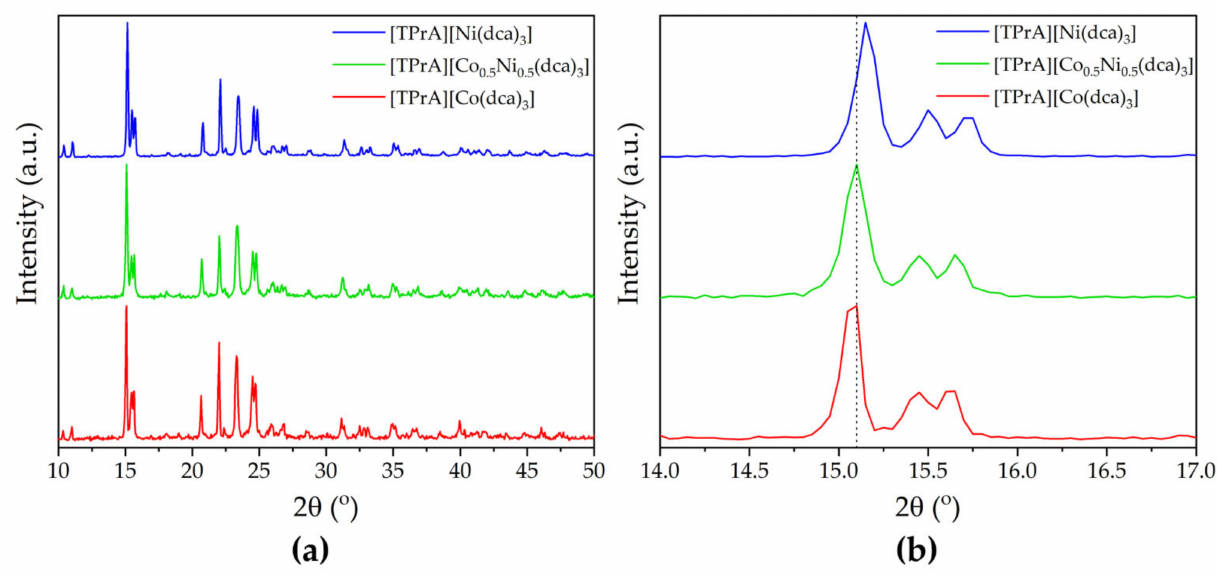
Figure 2. ( a ) Powder X-ray diffraction patterns of [TPrA][Co x Ni 1 − x (dca) 3 ], where x = 1.5, 0.5 and 0.0. ( b ) Details of a region of ( a ) to show the shape and the shift of the peak as x